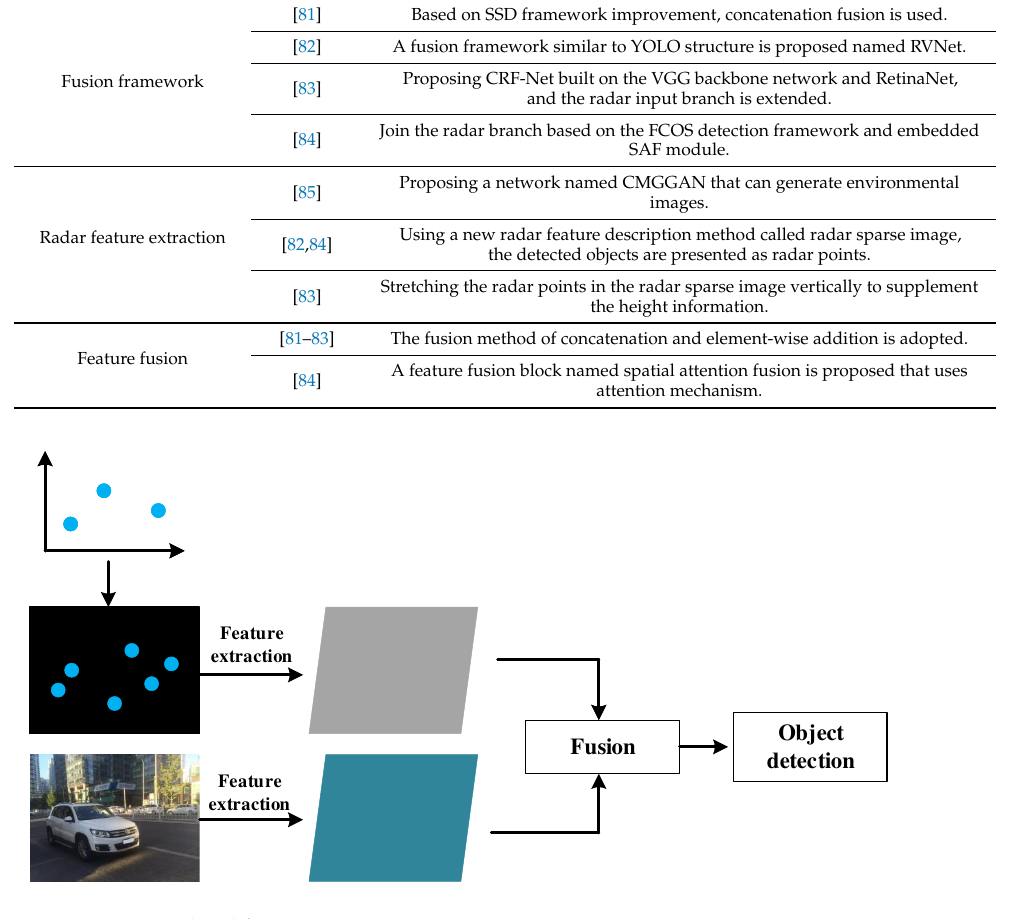
Figure 6. Feature level